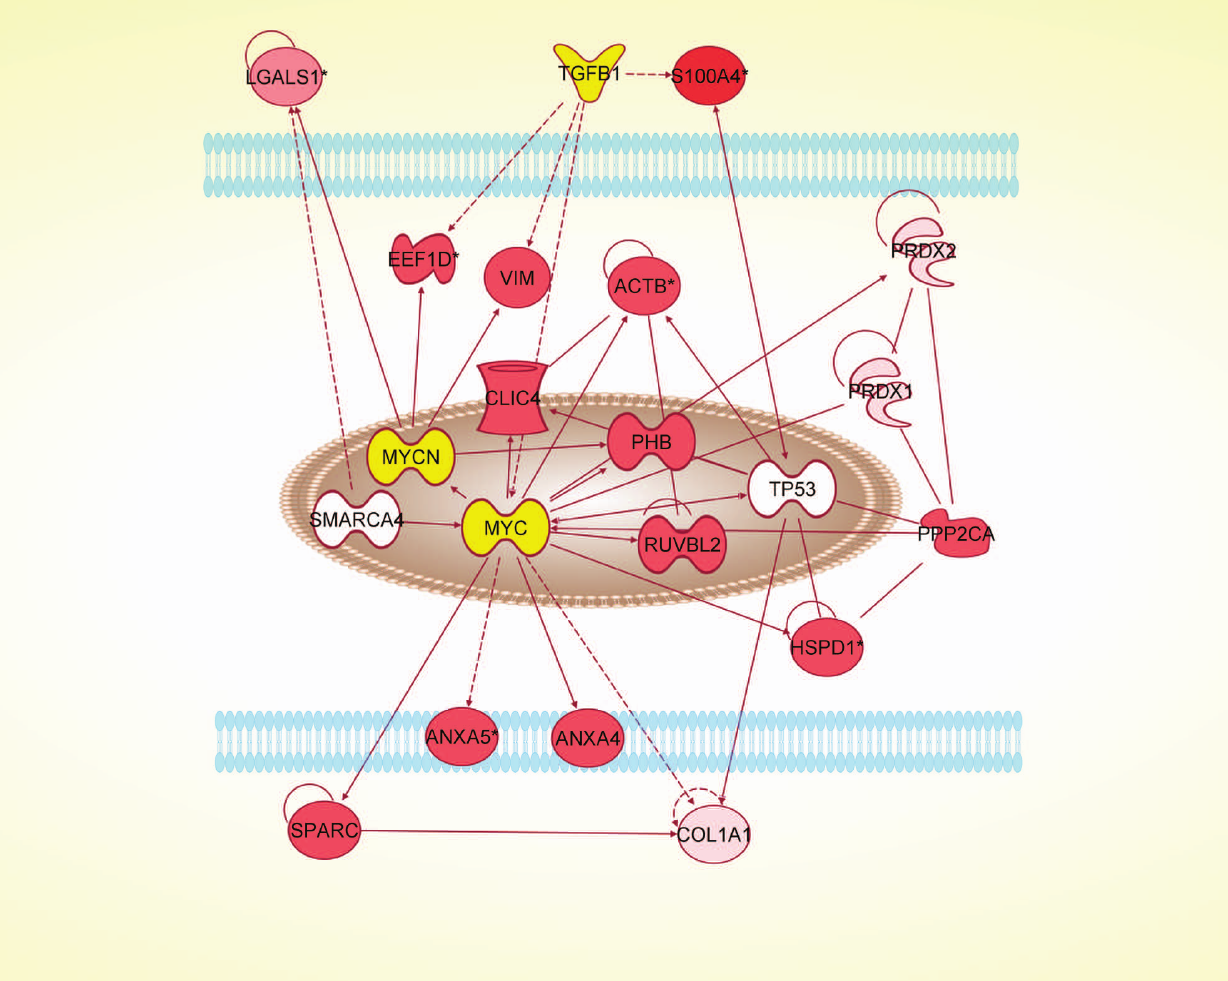
Figure 4. Network diagram for AP cells produced by IPA analysis. The diagram shows the potential interactions of the extracellular proteins with MYC and related transcription factors. AP cells, antlerogenic periosteum cells.